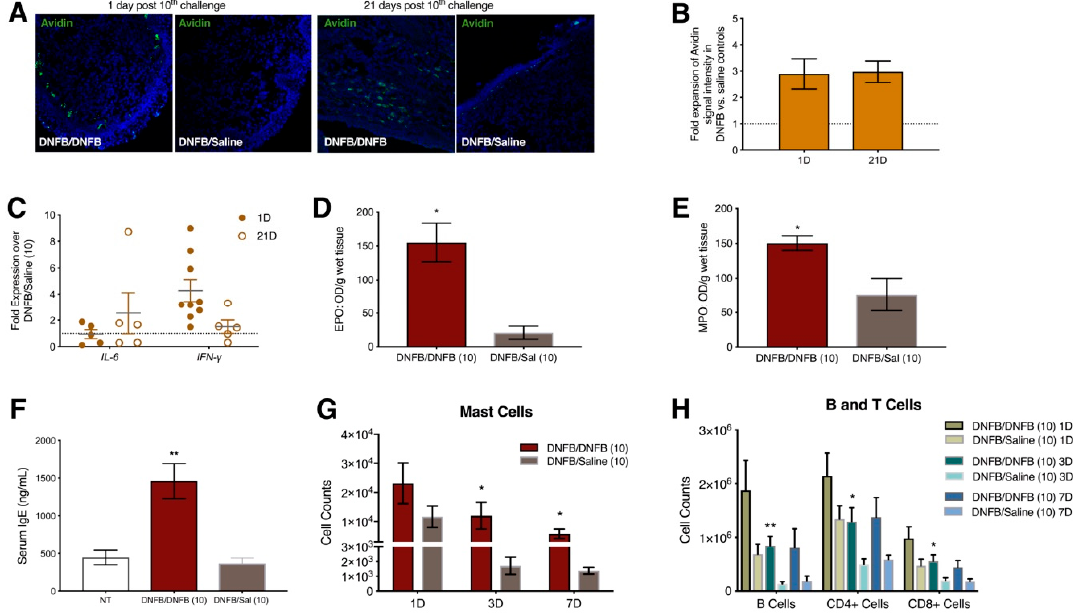
Figure 3. Repeated DNFB exposure in the vaginal canal provokes increased local mast cell density, upregulation of IL-6 and IFN- γ expression, increased IgE concentration in the serum, and increased numbers of B cells, T cells, and mast cells in the iliac lymph nodes. ( A ) Representative immunofluorescent images at 200X magnification of FITC-Avidin stained mast cells in vaginal canal tissue of DNFB and saline challenged mice 1 day and 21 days post 10 th challenge; ( B ) Relative fluorescent intensity of DNFB challenged mice 1 day and 21 days post 10 challenges compared to saline challenged mice. n = 3; ( C ) Relative transcript abundance of IL-6 and IFN- γ mRNAs in the vaginal canal tissue normalized to β 2-microglobulin (housekeeping) mRNA levels. n = 5–9; Local ( D )